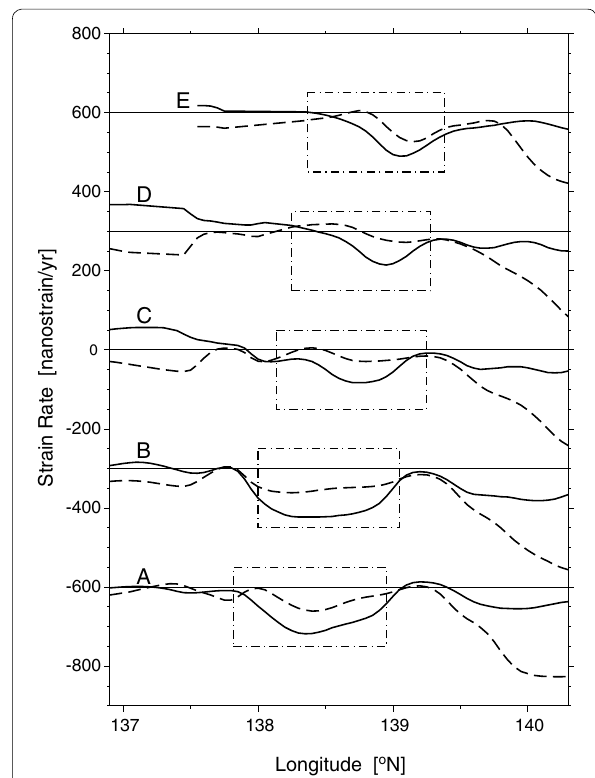
Fig. 2 E–W strain rate profiles for the preseismic (1997–2002; solid line) and postseismic (2013–2018; broken line) periods. These profiles are obtained by adding or subtracting offset (DC) components from the strain rate profiles shown in Fig. 1e, f (see the text). Note that the offset component corresponds to the longest wavelength component. The locations of the profiles, which are taken from 37.1°N (profile A) to 37.9°N (profile E) every 0.2°, are shown in Fig. 1. Adjacent profiles are drawn with an offset of 300 nanostrain/year, where the zero level of the profile C corresponds to “0” in the scale of the vertical axis. The dashed‑dotted box on each profile shows the region of the northern